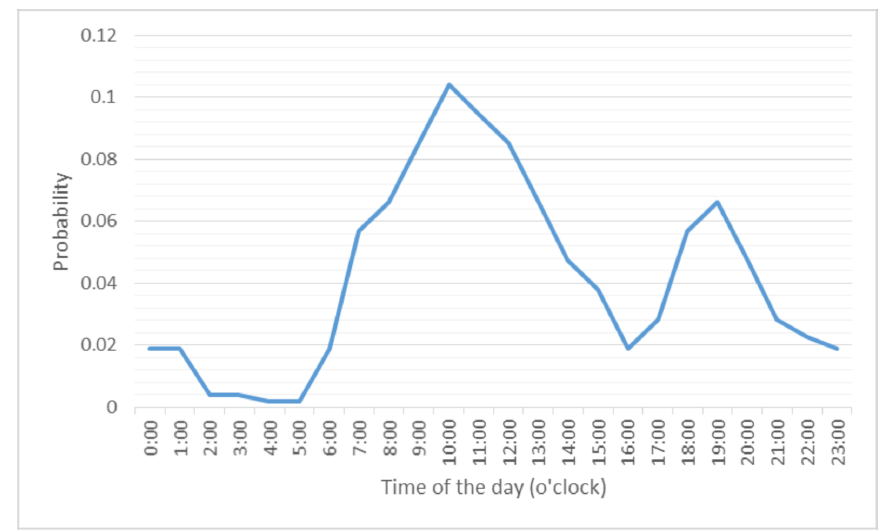
Figure 2. Arrival probability of